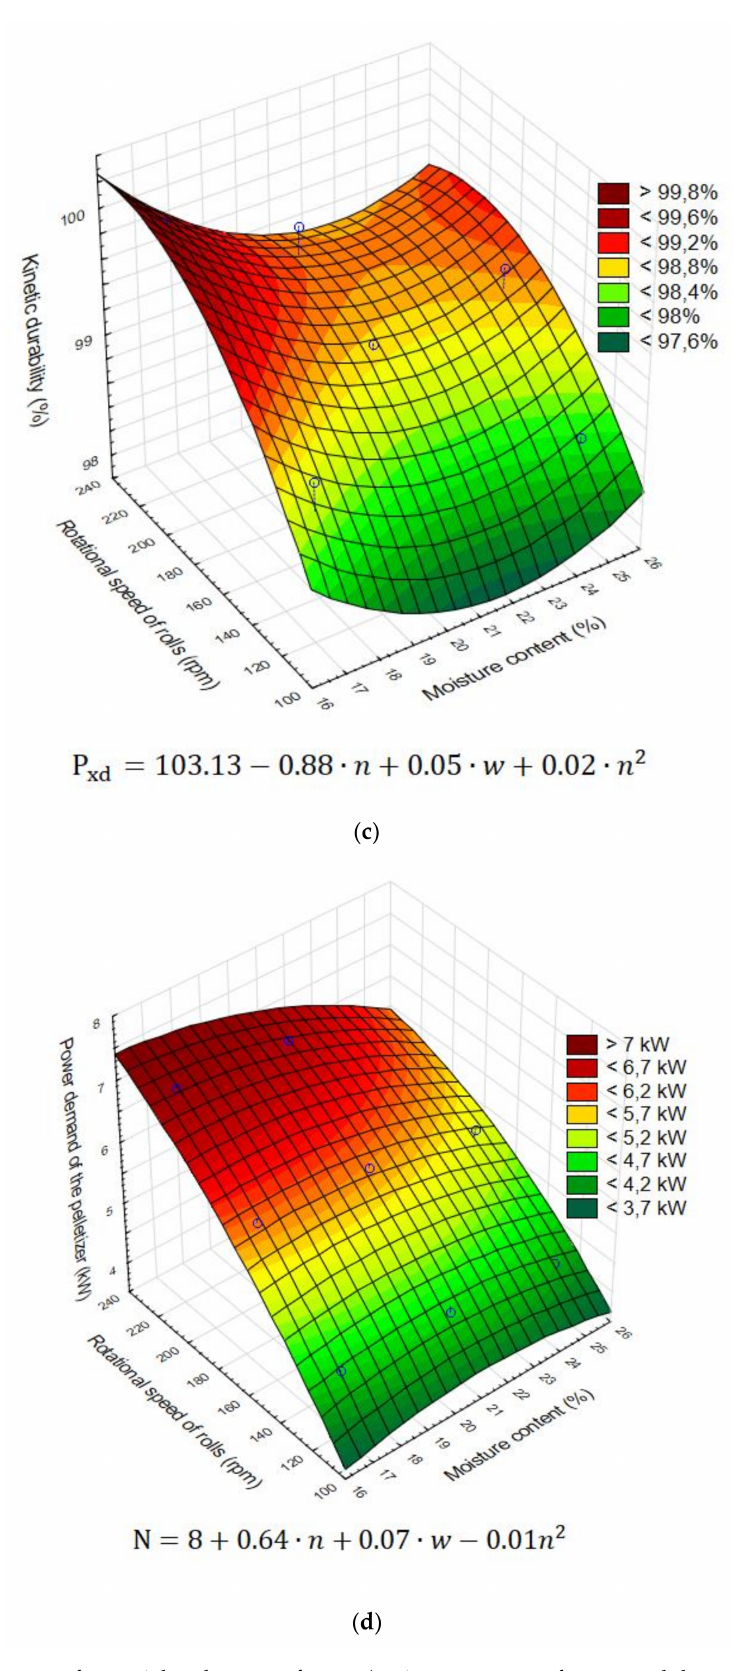
Figure 5. Influence of material and process factors (moisture content of waste and the rotational speed of the compacting rolls) on the ( a ) pellet density, ( b ) pellet bulk density ( c ) pellet kinetic durability and ( d ) power demand of the granulating